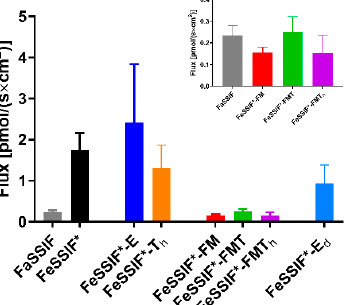
Figure 5. Absorptive flux values of abiraterone after rat intestinal perfusion of an abiraterone acetate suspension (0.5 mg/mL) in FaSSIF and in simulated fed state media. All media were supplemented with 80 IU/mL, except for FeSSIF* ‐ E d , in which pancreatin (0.83 mg/mL) was used. Insert depicts the absorptive flux values of abiraterone in FaSSIF and media containing fixed amounts of lipid digestion products. Data represent mean ± SD (n = 3; F = fatty acids, M = monoglycerides, T = triglycerides, T h = high triglycerides, E = Ensure Plus, E d = digested Ensure Plus).